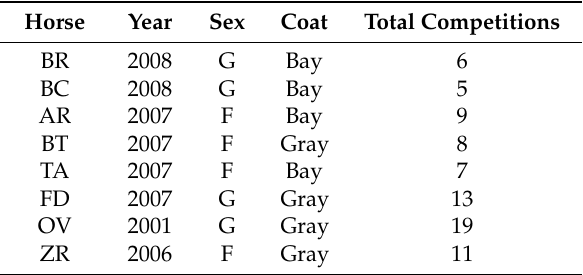
Table 1. Details of the horses included in the trial, with their birth year, sex (G stands for gelding and F for female), coat color, and number of previous competitions.